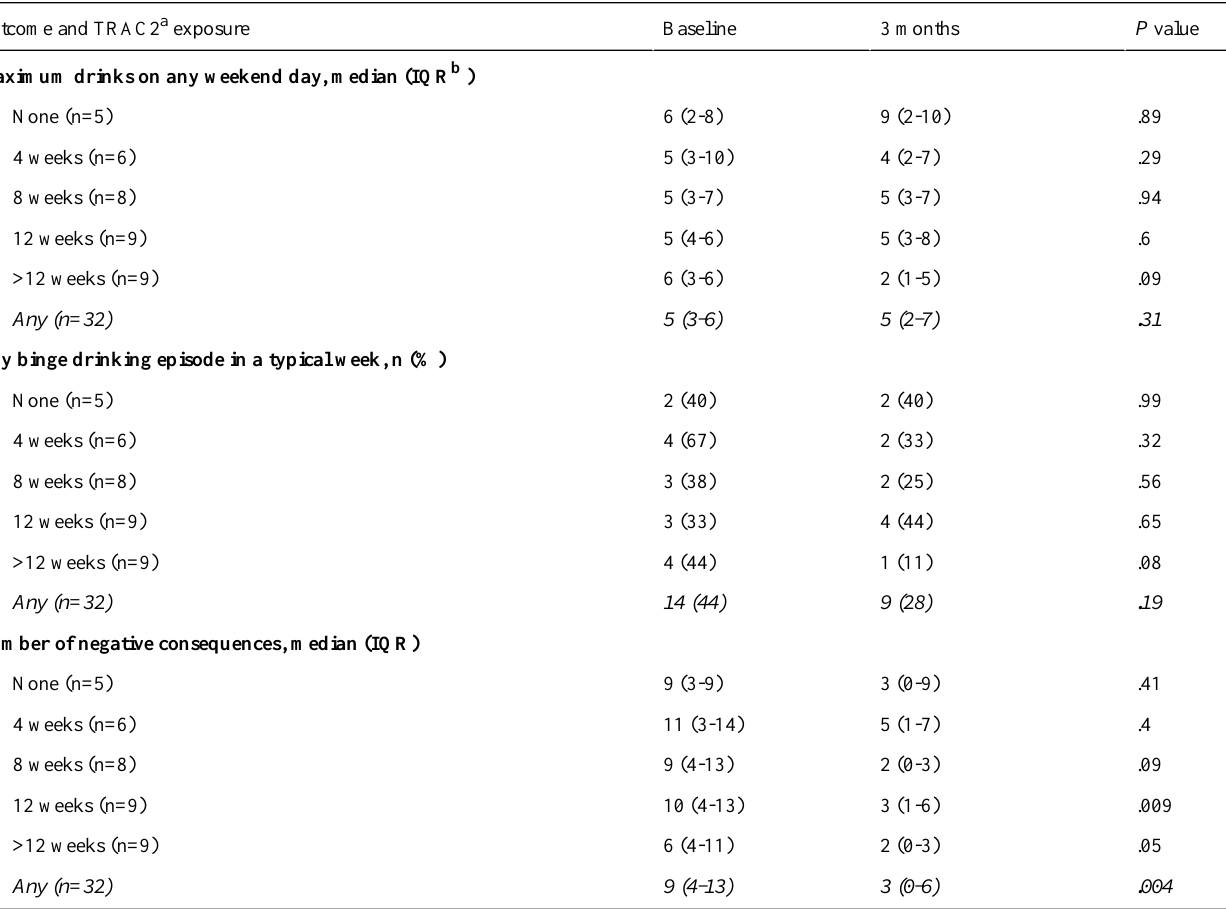
Table 2. Change in alcohol-related outcomes from baseline to 3-month follow-up (Wilcoxon signed-rank tests for max drinks and negative consequences and 2-sample test of proportions for prevalence of any binge drinking episode in a typical week). Text in italics represents a summary of the other